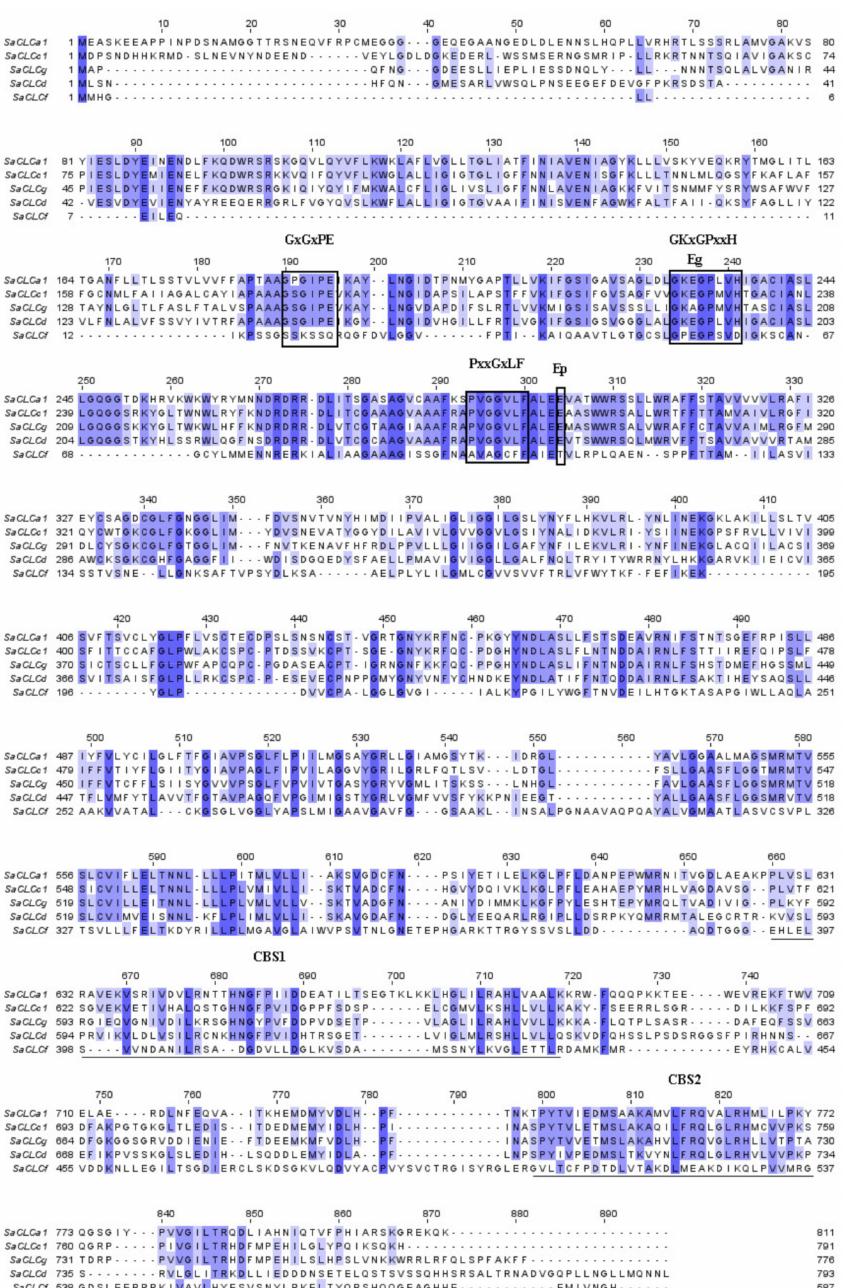
Figure 1. Alignment of the amino acid sequences of CLC proteins from S. altissima : SaCLCa1 (GenBank, acc. no. ANG09048.1), SaCLCc1 (GenBank, acc. no. AVQ93350.1), SaCLCd (GenBank, acc. no. OK626332), SaCLCf (GenBank, acc. no. OK626333), and SaCLCg (GenBank, acc. no.